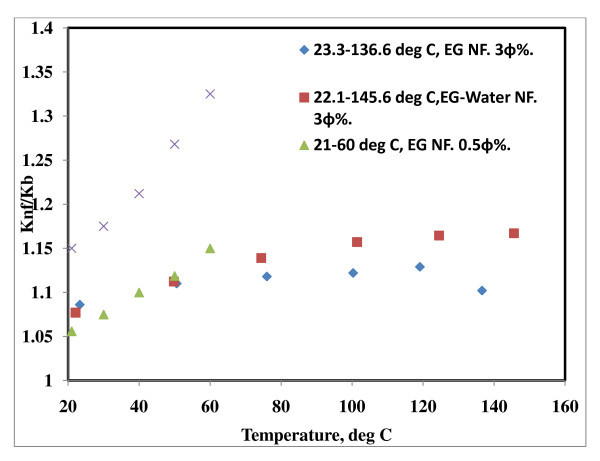
Effect of temperature on EG and EG + H2O-based Al2O3 nanofluids. 23.3 to 136.6, EG NF, 3 φ% [22]; 222.1 to 145.6, EG-water NF, 3 φ% [22]; 21°C to 60°C, EG NF, 0.5 φ% [20]; 21°C to 60°C, EG NF, 1.0 φ% [20].